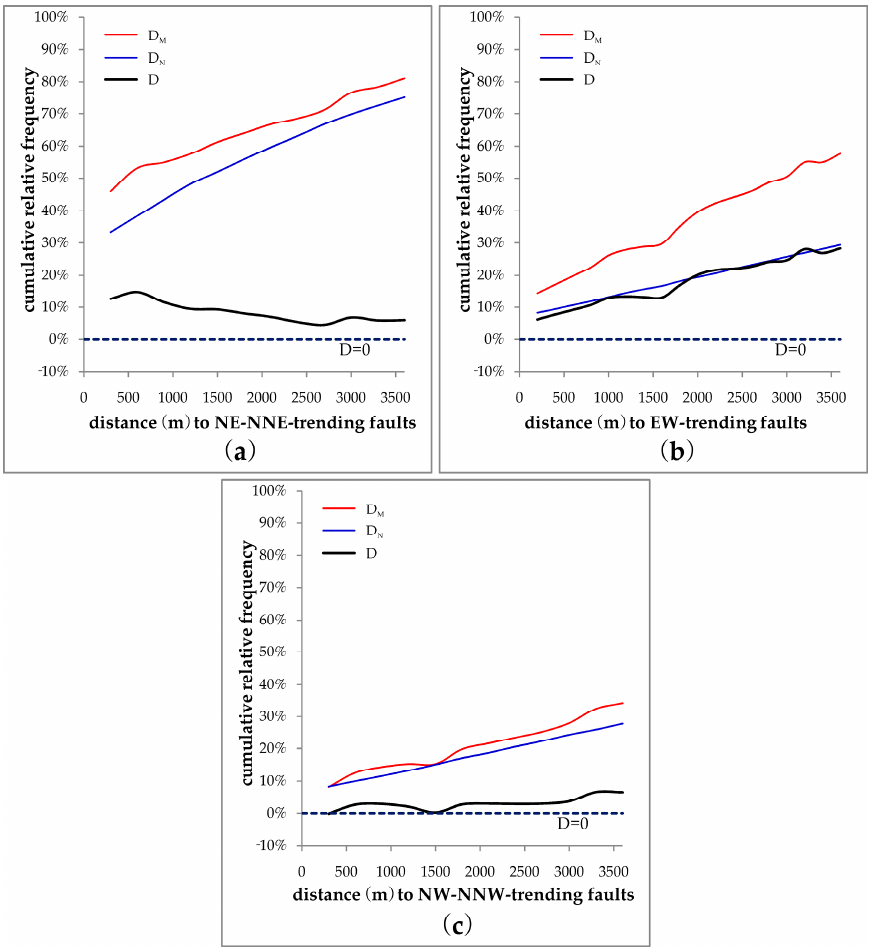
Figure 4. Graphs of cumulative frequency of distances from tungsten occurrence ( D M ) and non-occurrence locations ( D N ) to ( a ) NE–NNE-trending faults, ( b ) EW-trending faults, and ( c ) NW–NNW-trending faults. D is the difference between D M and D N .